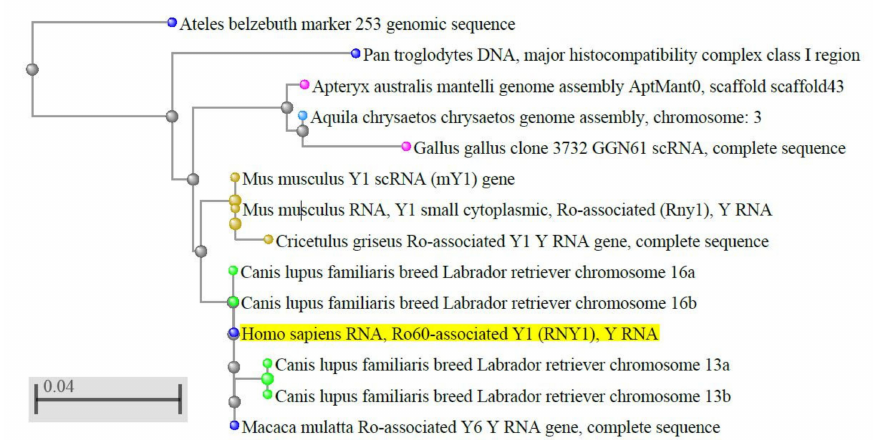
Figure 1. Evolutionary conservation of Y RNA in vertebrates. The dendrogram shows the conservation of human hY1 in monkeys, dogs, rodents, and birds; only best matches (identity > 95%) were selected. The tree was obtained through the NCBI BLAST website (URL: https: // blast.ncbi.nlm.nih.gov / Blast.cgi, accessed on April 2020), using default settings. Out of the 100 results displayed, we selected only those coming from genome sequences, thus excluding predicted sequences, human pseudogenes, bacterial artificial chromosome (BAC) clones, and other constructs. The color codes, set by default by the NCBI website, are as follows: yellow highlight: query sequence; light blue dots: hawks and eagles; pink dots: birds; brown dots: rodents; blue dots: primates; green dots: carnivores; grey dots: